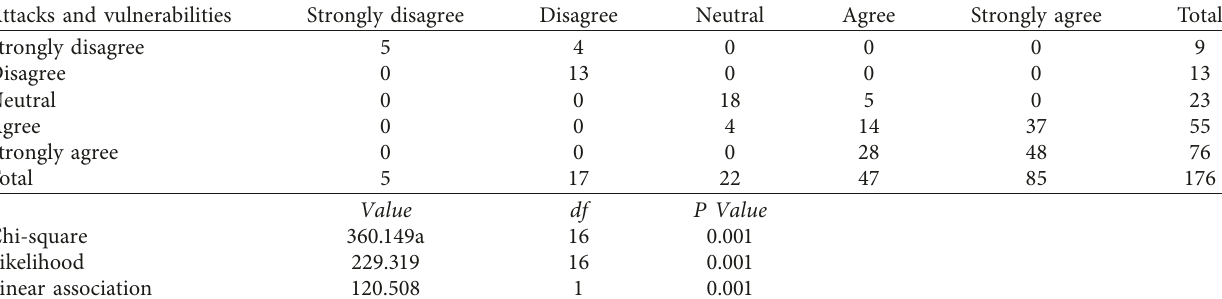
Table 6: Cross tab of attacks and vulnerabilities ∗ drug traceability cross